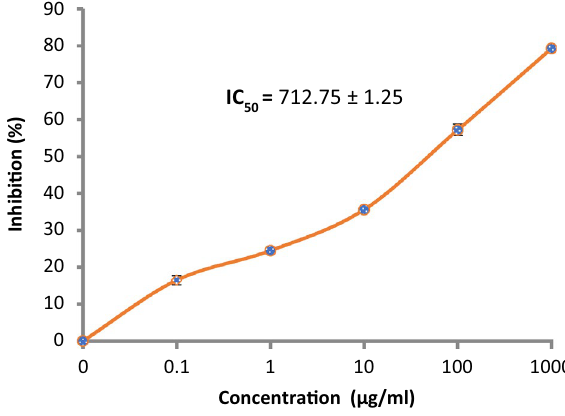
Figure 5. Cytotoxicity of D. caffra fruit extract against